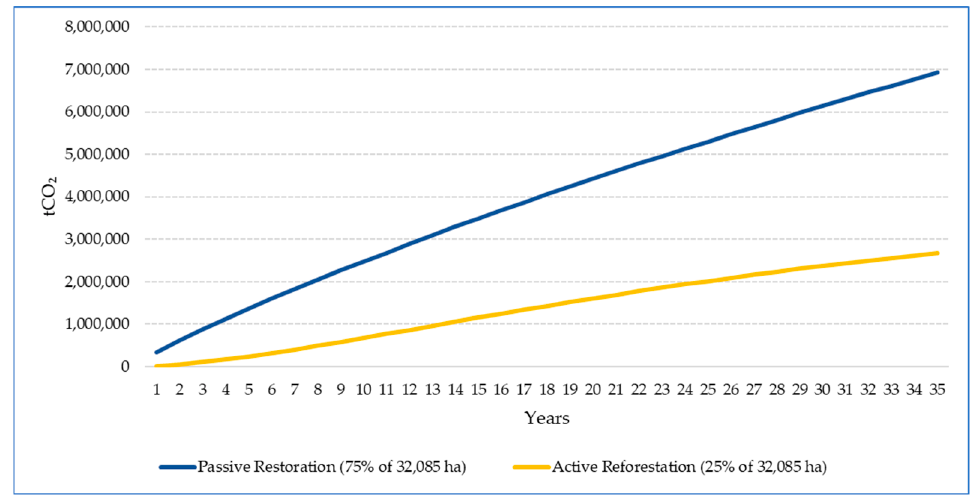
Figure 4. Cumulative carbon sequestration for passive and active restoration (tCO 2 ).